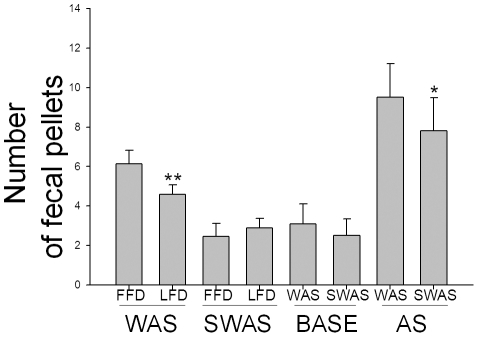
Number of fecal pellets.Number of the fecal pellets in water avoidance stress (WAS) and sham water avoidance stress (SWAS) rats at the first five days (FFD) or the last five days (LFD) and at the base state (BASE) or acute stress state (AS) on the eleventh day. Data are expressed as mean ± SEM (n = 10). Statistical significance of difference between fecal pellet counts in WAS and SWAS rats at FFD or LFD and BASE or AS was evaluated by using unpaired Student's t-test. **P<0.01, * P<0.05 compared between WAS and SWAS.